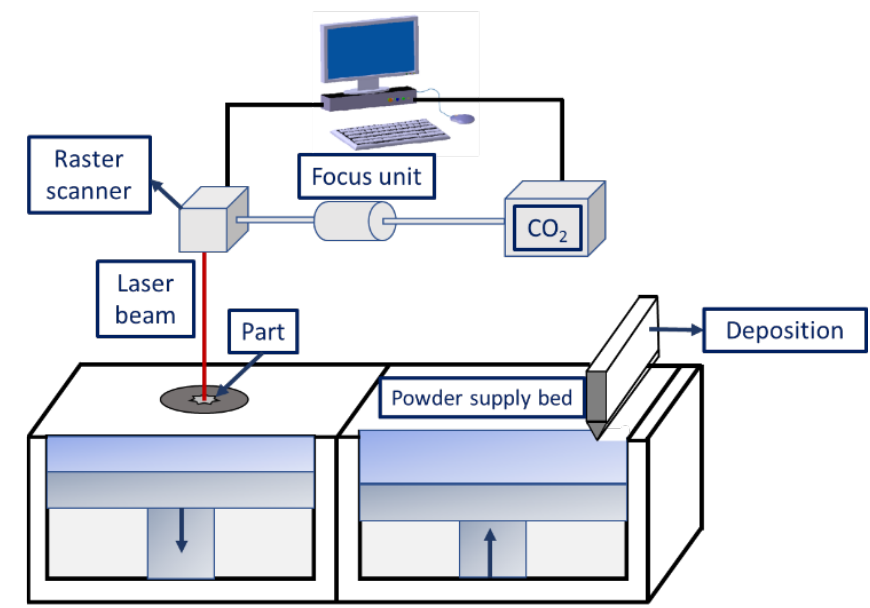
Figure 4. Schematic diagram illustrating the selective laser sintering process.